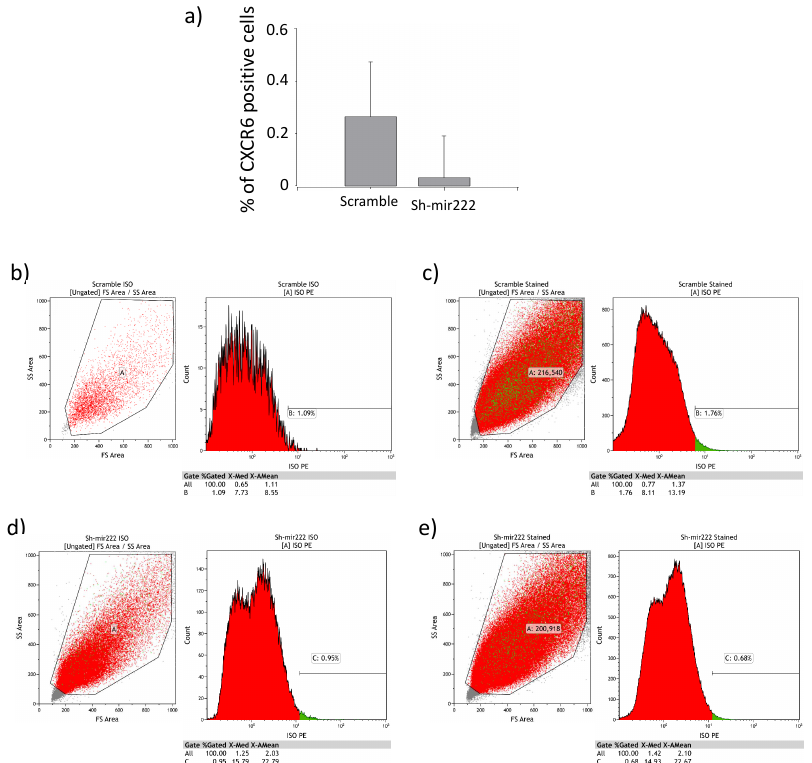
Figure A5. Level of expression of CXCR6 in IgR39 cells transfected with hsa-miR-222-5p inhibitor (sh-mir222) or scramble sequence (scramble) as control. Sh-mir222 and scramble cells were obtained as described in the Materials and Methods section. Cells were analyzed for phycoerythrin (PE) anti-human CXCR6 (cod. MAB699 R&D System, Minneapolis, MN). For each flow cytometry evaluation, a minimum of 10 6 cells were stained. Flow cytometry and analysis was performed using a Gallios flow cytometer (Beckman Coulter Indianapolis, IN, USA). ( a ) Average fraction of CXCR6 positive cells and standard errors over three replica. ( b – e ) Distribution of fluorescence signal for control cells stained with isotype antibody ( b , d ) and CXCR6-stained cells ( c , e ) in a typical experiment. Positive, selected cells are reported in green in both dotplots and histograms. Median and average fluorescence intensity is reported below each